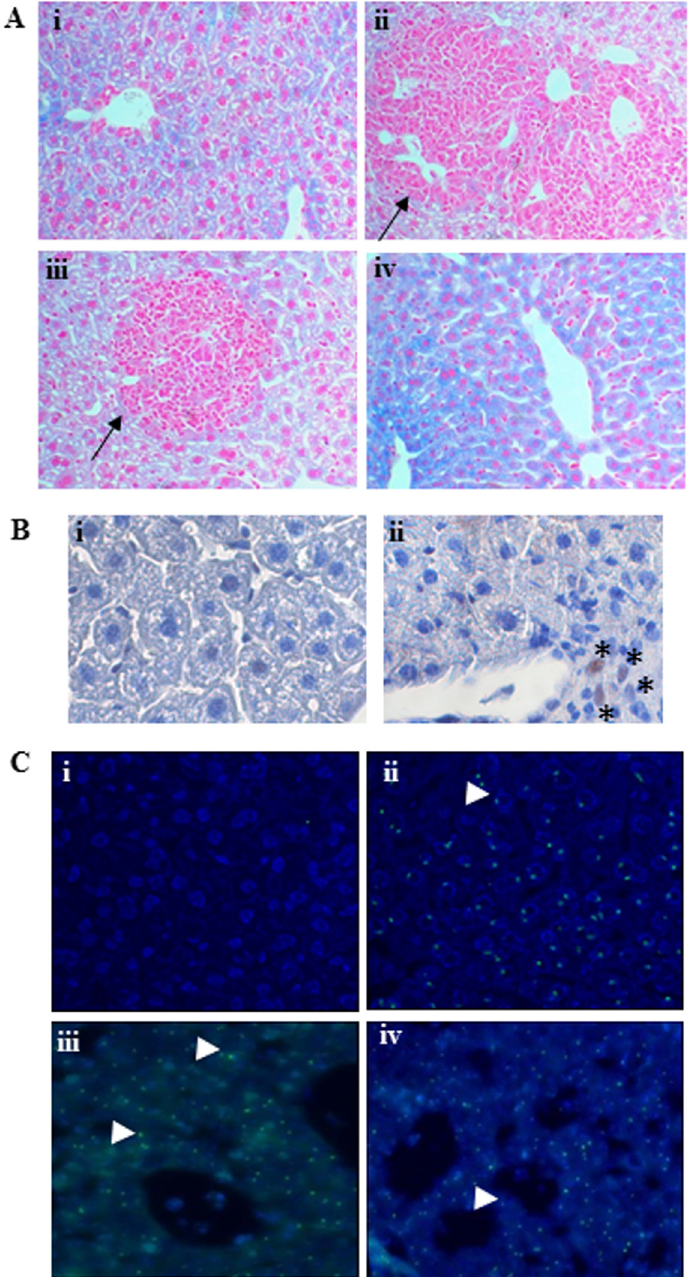
Fig 5. Engraftment of Liv2-sorted GPSC-derived hepatocytes in mouse liver 5 days after injection. A: Engraftment of GPSC-derived hepatocytes in Hfe-null mice livers 5 days post injection. Paraffin-embedded liver sections from control mice were stained with Perls which revealed iron deposits (cytoplasmic blue staining) in endogenous hepatocytes (i) (Magnification:10X). Several areas of regeneration (negative for Perls staining) were evident in the livers of Hfe-null mice which underwent cell tranplantation (ii, iii, arrows). Engraftment was regional and heterogenous; some areas of the injected lobes did not show visible signs of regeneration (iv). B. Anti- PCNA staining of liver sections from Liv2-sorted cells-injected mice to check for cell proliferation. The endogenous hepatocytes (i) do not proliferate while proliferation of cells (ii, * ) in the Perls ’ - negative, regenerating areas was observed. C. Fluorescent in situ hybridization (FISH) was performed to analyse for the presence of Y chromosome (green dots). The Perls ’ -negative cells were positive for Y- chromosome (iii,iv, arrowheads), indicating the provenience of these cells compared to untreated female livers (i). Male livers were used as positive control for FISH(ii). Representative images are shown (n = 6).